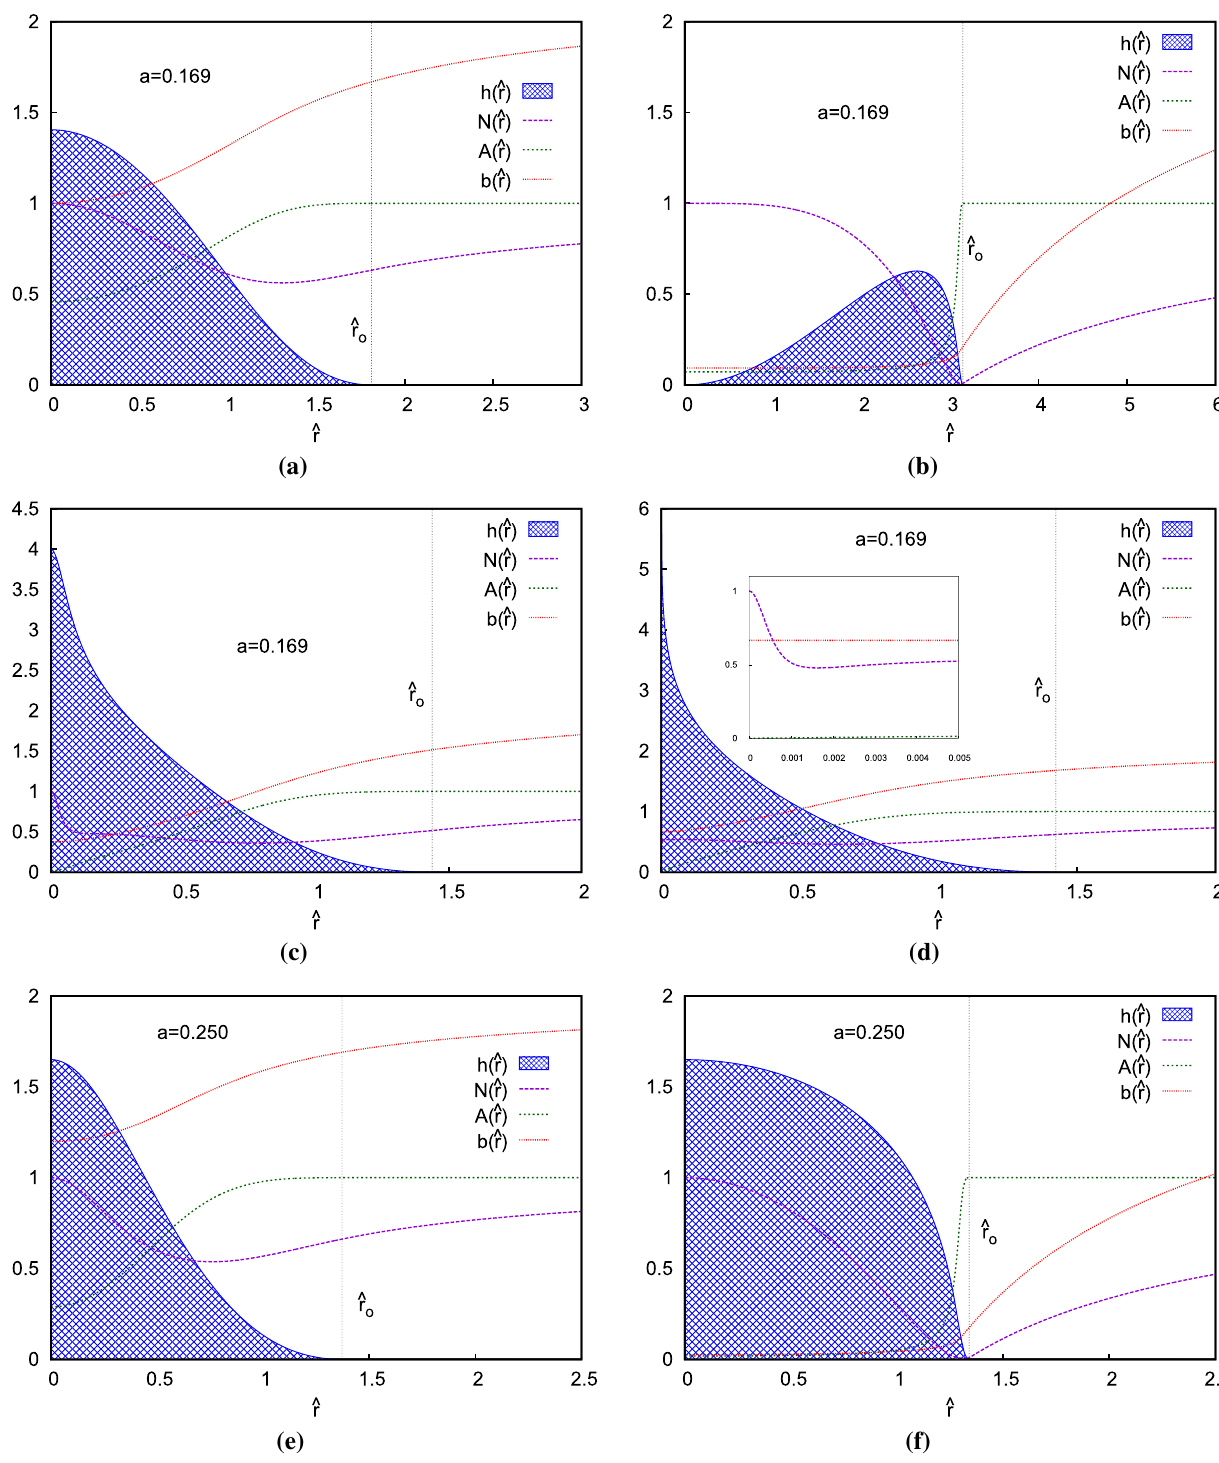
Fig. 9 a – f The distribution of the four field variables h ( ˆ r ) , N ( ˆ r ) , A ( ˆ r ) and b ( ˆ r ) versus the dimensionless radial coordinate ˆ r ), for the ranges shown (which are solutions of the set of four coupled nonlinear differ- ential Eqs. (16)–(19)). a – d Here correspond to the representative points